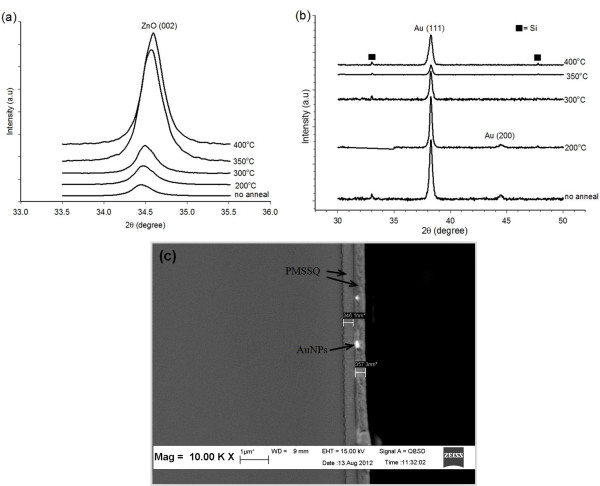
ZnO seed layer template, AuNP growth, and MIS memory device. XRD spectra of the (a) sputtered ZnO seed layer template annealed at various temperatures. (b) Corresponding AuNP growth using the ZnO seed template annealed at various temperatures. (c) Cross-sectional view of the MIS memory device for the sample annealed at 400°C.